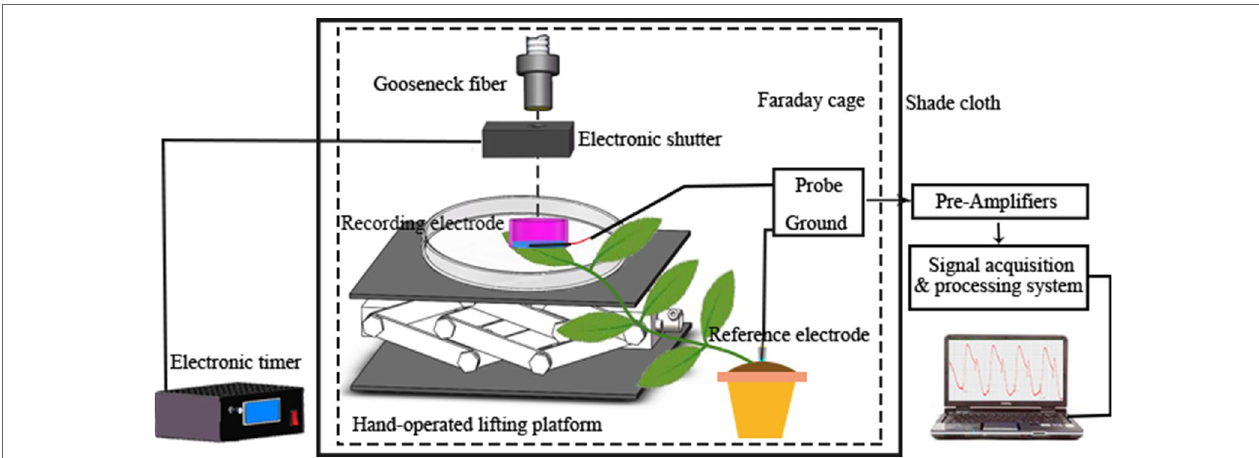
FIgURe 1 | Schematic diagram of the system for electrical signal